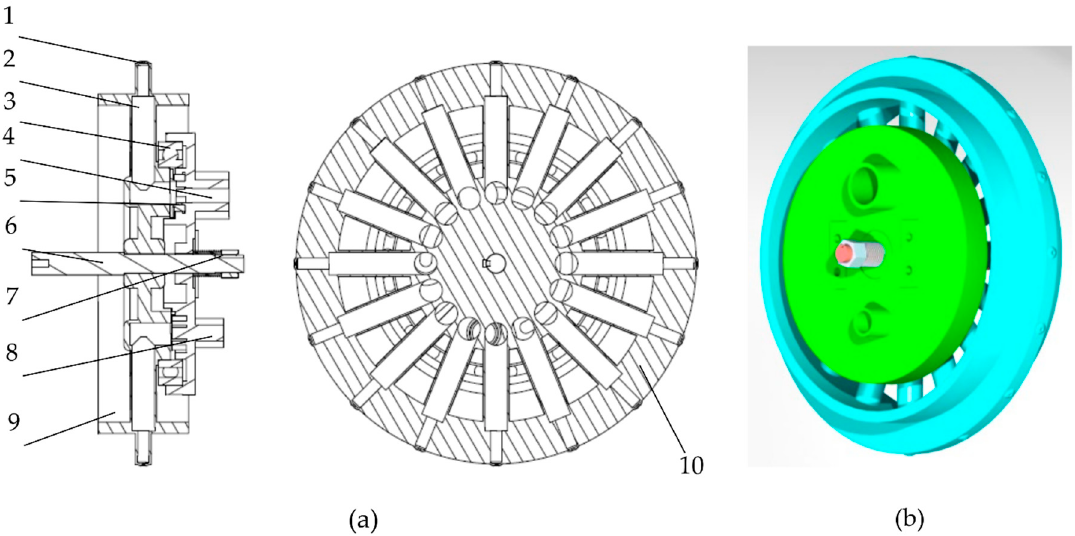
Figure 1. Schematic diagram and three-dimensional modeling of seeding wheel structure. ( a ) Schematic diagram of seeding wheel structure: (1) seed-sucking hole; (2) airway; (3) thin-walled bearing; (4) negative pressure aperture; (5) rubber sealing ring; (6) seeding axle; (7) locking mechanism; (8) positive pressure aperture; (9) outer wall; (10) seed-sucking boss; ( b ) three-dimensional modeling of seeding wheel structure.